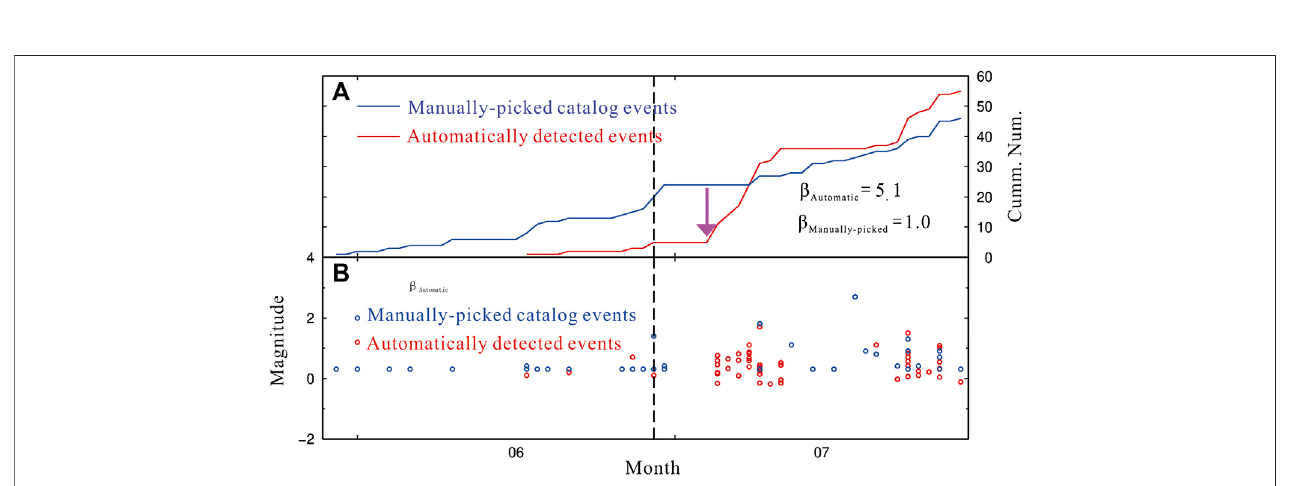
FIGURE 5 | (A) β -statistic values of automatically detected (red curve) and manually picked (blue curve) catalogues. (B) Changbaishan volcanic earthquake activities before and after the 2002 Wangqing deep-focus earthquake. The purple arrow marks the onset of volcanic unrest (i.e., July 5, 2002).